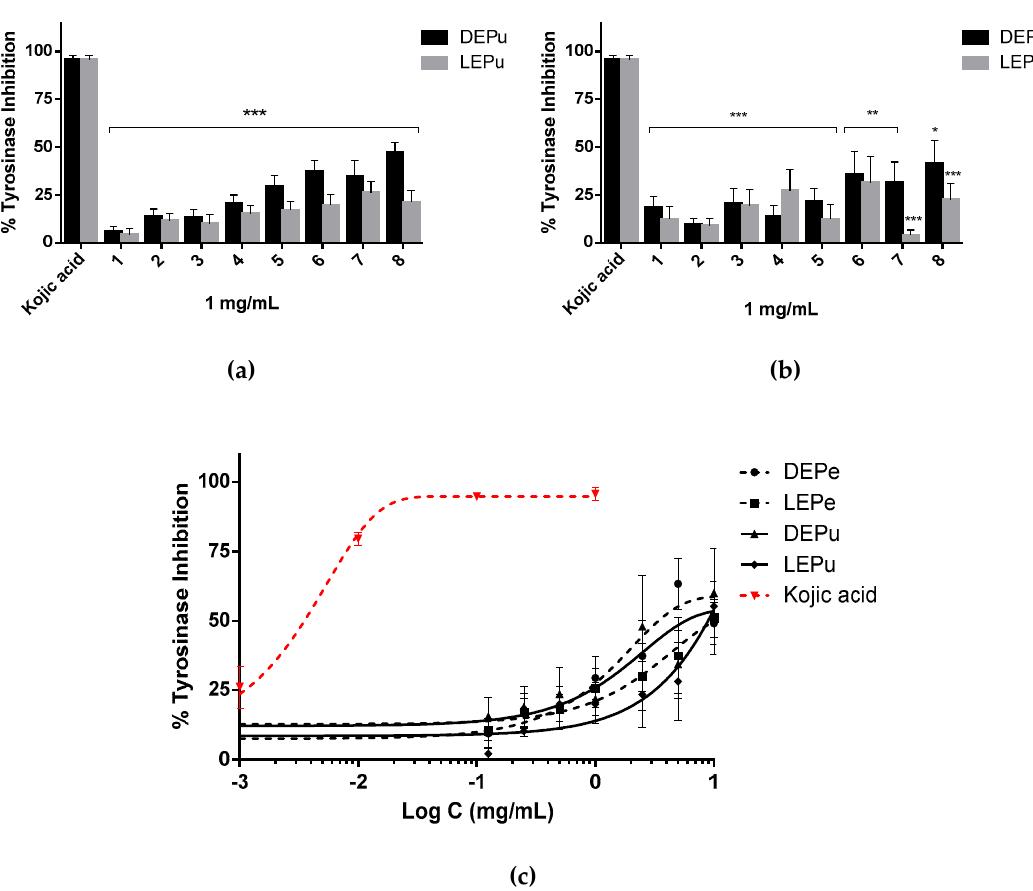
Figure 5. TYR inhibition: ( a ) inhibition performed by extracts obtained from pulp ( n = 3); ( b ) inhibition performed by extracts obtained from peel ( n = 3); ( c ) inhibition performed by sample 5 for DEPe and DEPu, sample 6 for LEPe and LEPu, and kojic acid in a concentration dependent manner ( n = 3). One-way analysis of variance (ANOVA) followed by Dunnet’s test for multiple comparisons: * p < 0.05; ** p < 0.01; *** p < 0.001 against kojic acid. DEPe: dried peel methanolic extract; LEPe: